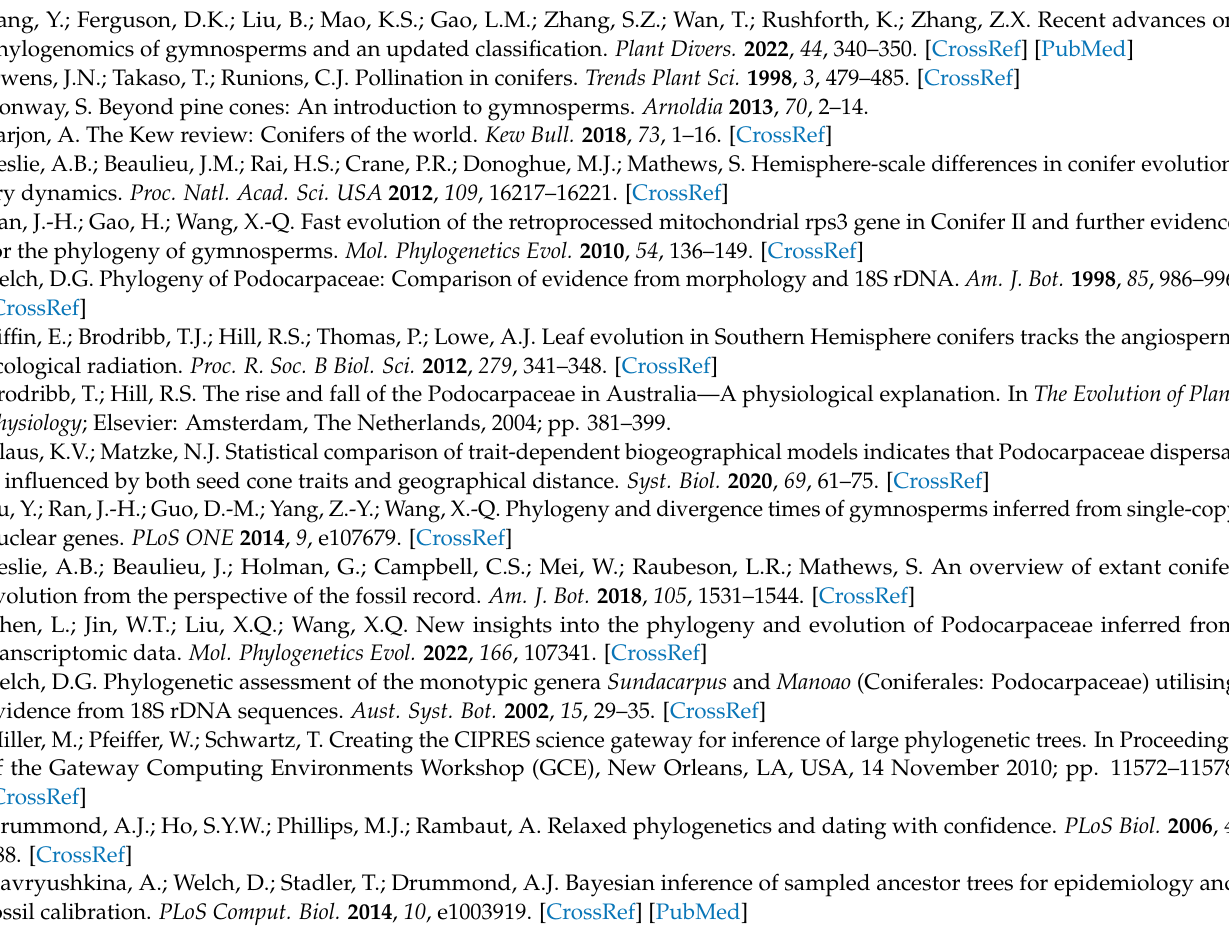
Table S1. Fossil taxa used for calibration of the phylogeny